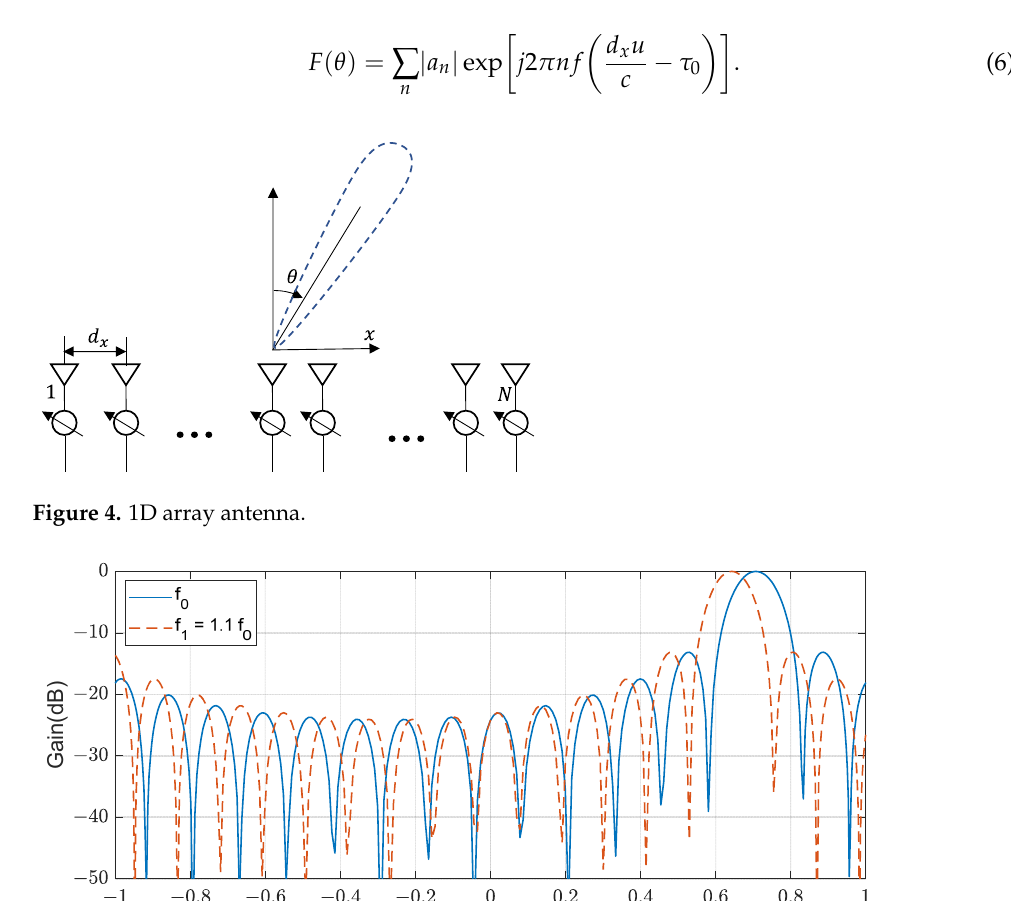
Figure 3. Baseband true noise generation block.